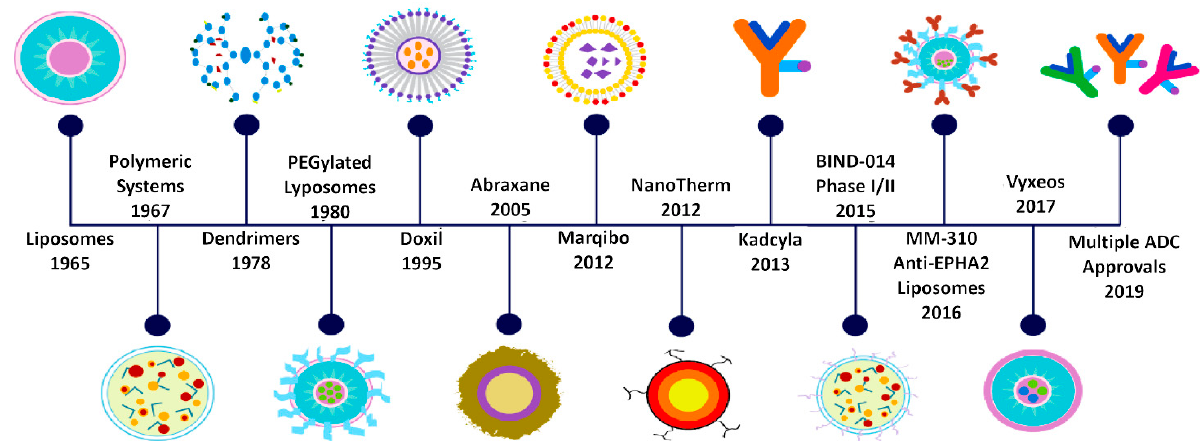
Figure 2. Schematic representation of the evolution of NCs towards targeted nano carriers (TNCs) in clinical cancer treatments. Some NCs formulations approved or in clinical trials, based in lipid (Doxil, Marqibo, MM-310; Vyxeos), inorganic (AMAG, NanoTherm), natural molecules (ABI-009, Abraxane), and polymers (BIND-014; AZD2811), as well as engineering monoclonal antibody for target treatment (SGT-53, Kadcyla: Traszumab conjugate with emtansine). Reprinted with permission from Ref. [275].